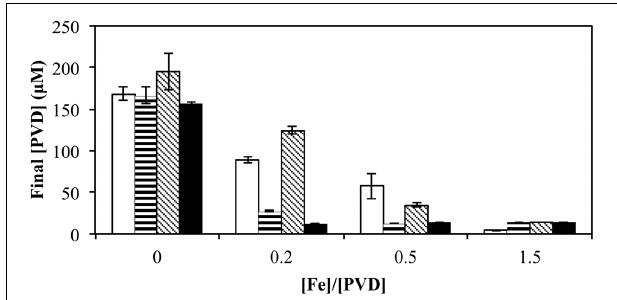
FIGURE 8 | Concentration of PVD observed 2 days after the addition of varying concentrations of FeCl 3 to P. putida GB-1 cultures supplemented with 10 µ M of each indicated PVD. No PVD (open bars), PVDGB-1 (horizontal lines), PVD KT2440 (diagonal lines), and PVD PCP1 (filled). [Fe(III)] = 0, 2, 5, and 15 μ M (added as FeCl 3 ) and added [PVD] = 10 μ M. Error bars indicate the standard deviation of PVD assays of triplicate